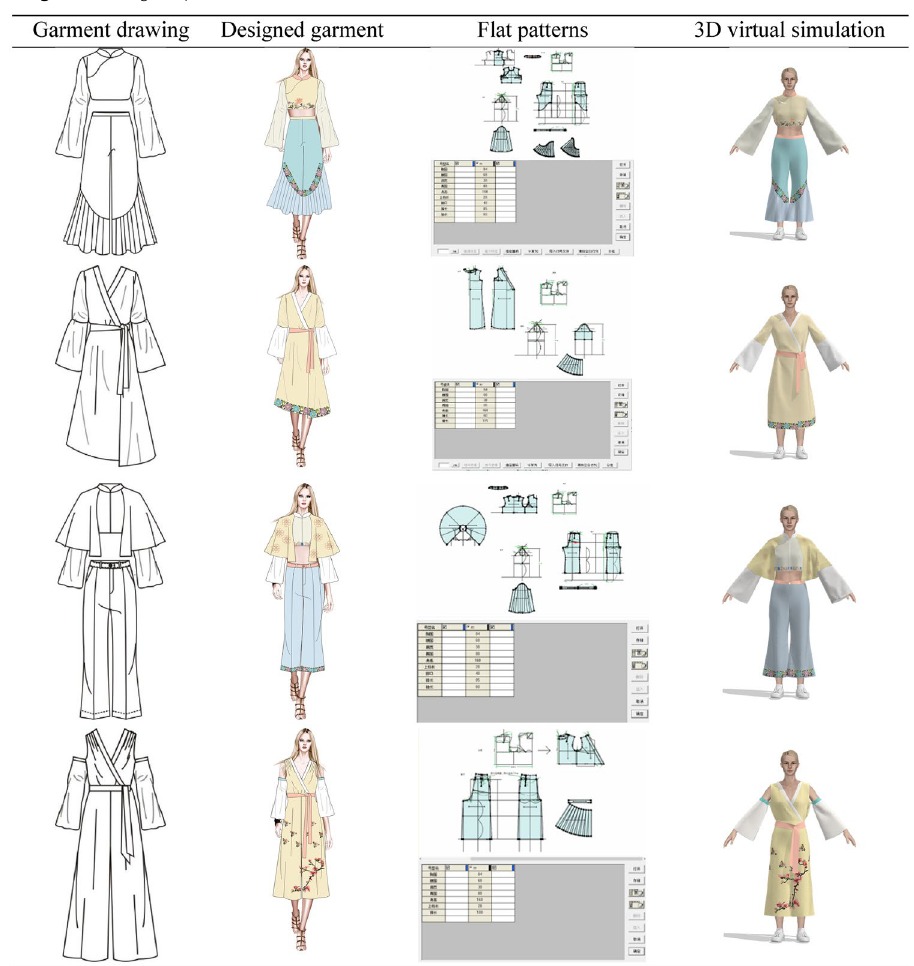
Fig. 8 Clothing flat patterns and simulation